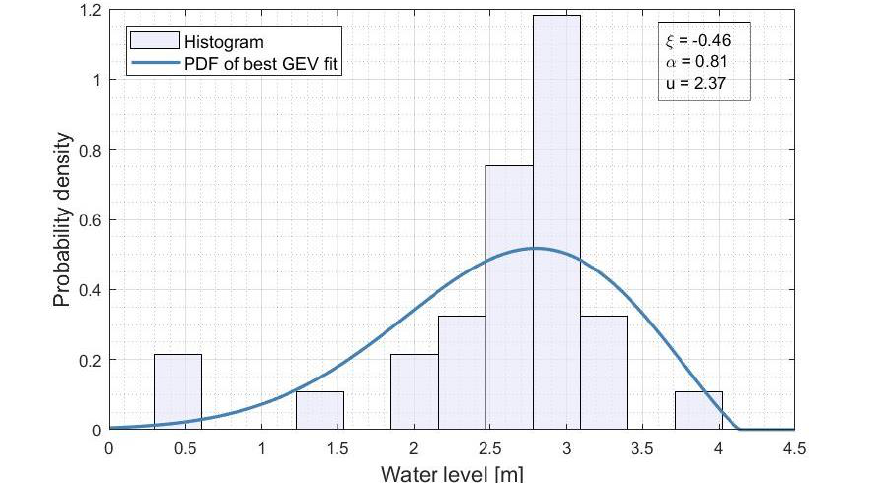
Figure 6. The histogram of yearly maximum water levels and the probability density function of the fitted reverse Weibull distribution.